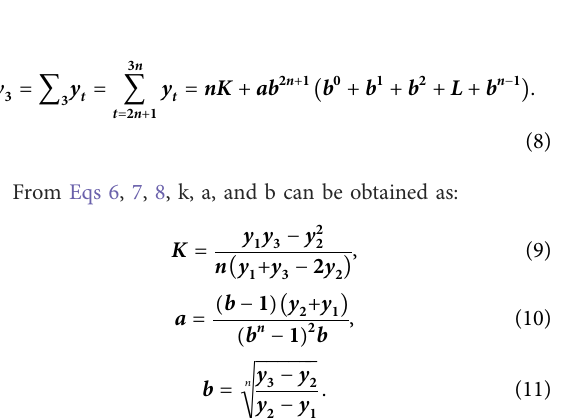
FIGURE 12 Average rate of viscosity